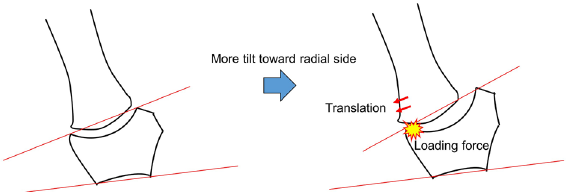
Figure 4. Mechanism of the distribution of subchondral bone density in the articular surface of the trapezium. The distribution of subchondral bone density is more likely to gather in the radial-dorsal region because of radial translation of the first metacarpal, if trapezial inclination is